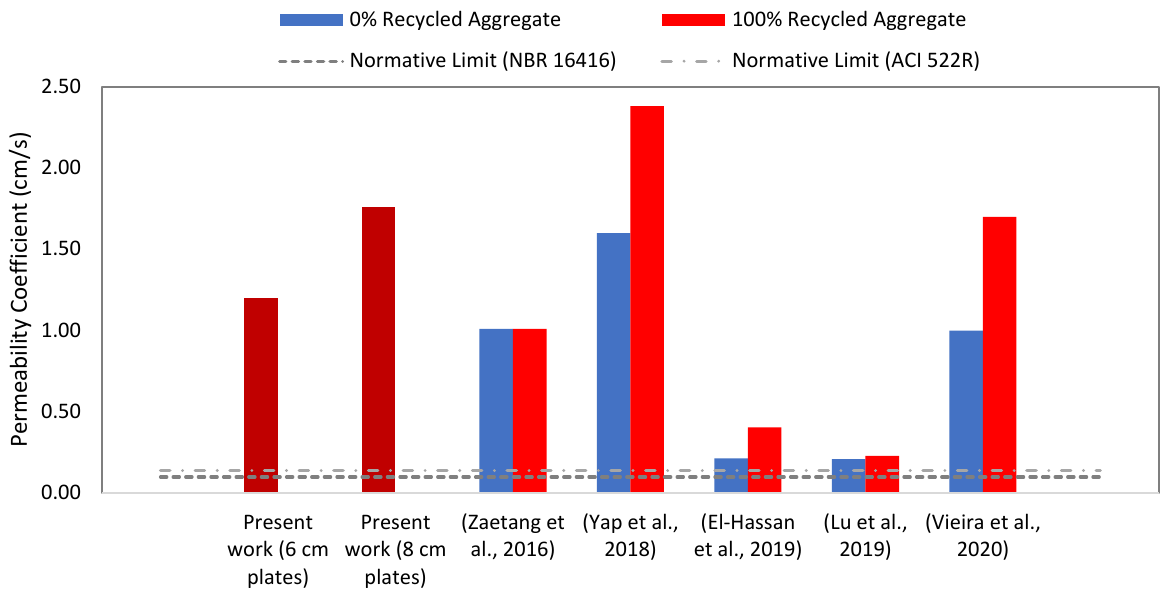
Figure 15. Comparison between the permeability coefficient values obtained in this study and in the literature.